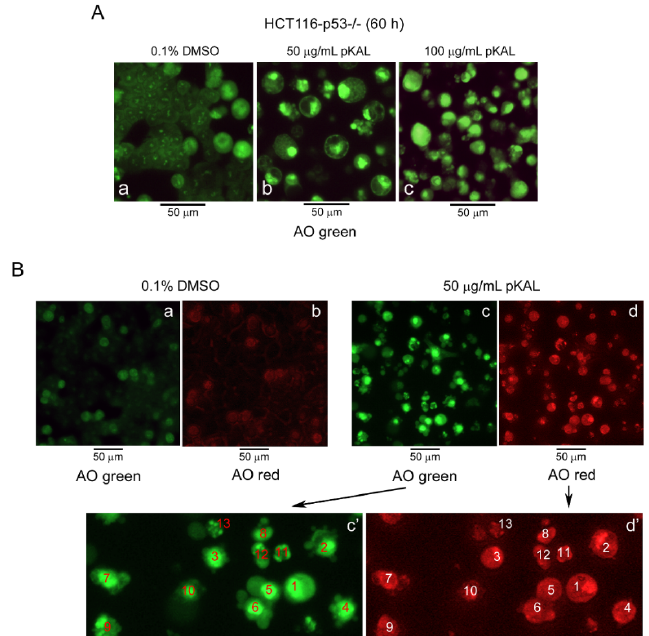
Figure 2. Effects of pKAL on DNA conformational change and acidic vesicle formation in p53-null HCT116 cells. HCT116-p53 − / − cells were grown for 60 h at the indicated concentration of DMSO or pKAL. ( A , B ) Cells were stained with 1 µg/mL acridine orange (AO), and fluorescent images for green and red were visualized by fluorescence microscopy.